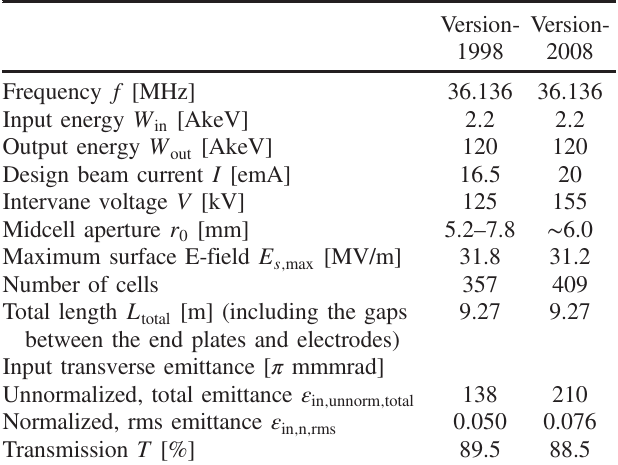
TABLE I. Main design parameters of the two constructed HSI